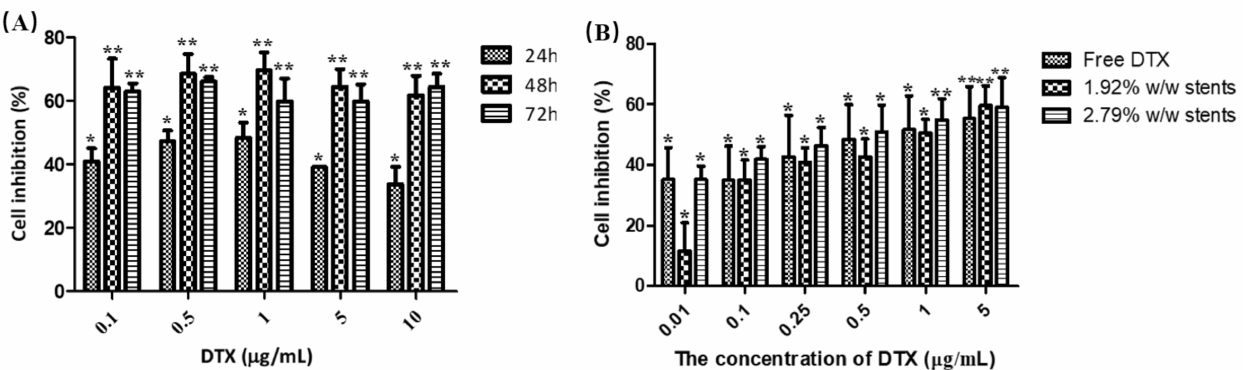
Figure 4. Cell inhibition caused by ( A ) various concentrations of pure DTX incubated with human oesophageal cancer cells (KYSE30) for 24, 48 and 72 h, and ( B ) various concentrations of pure DTX and DTX released from the stents incubated with KYSE30 cells for 48 h, as measured using a MTT assay ( B ). Data are presented as the mean ± SD of at least three independent experiments. * p < 0.05, ** p < 0.01 vs. untreated group. ( n =